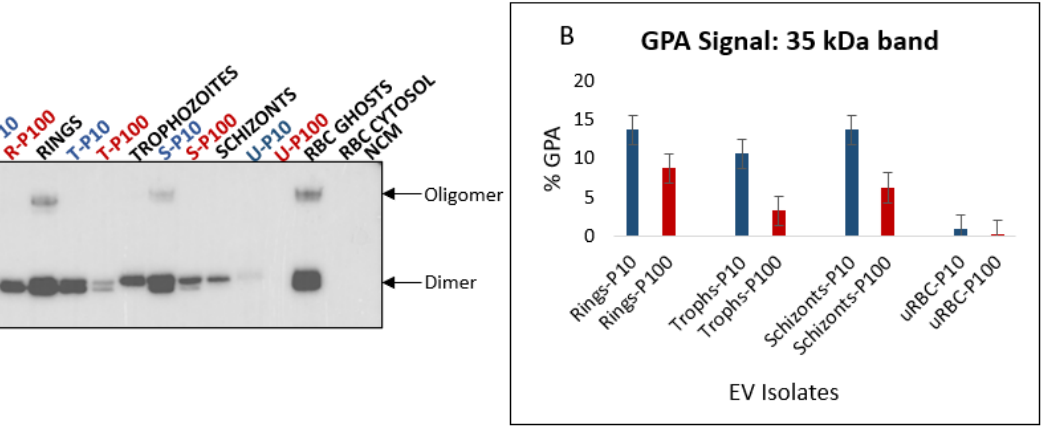
Figure 8. ( A ) Western blot analysis of GPA in EVs (blue and red) and lysates of parent cells from which the EVs were released (black). GPA is a transmembrane protein and an RBC specific EV marker; observed molecular weights are a 35 kDa dimer and 90 kDa oligomer. Lower molecular weight cleavage product can be observed for both the dimer and oligomer. ( B ) Densitometric anal- ysis of 35 kDa GPA dimer in EVs. GPA is more enriched in iRBC P10 than iRBC P100 EVs. All iRBC EVs have significantly more GPA than uRBC EVs; P10 EVs–blue, P100 EVs–red, cell lysates and